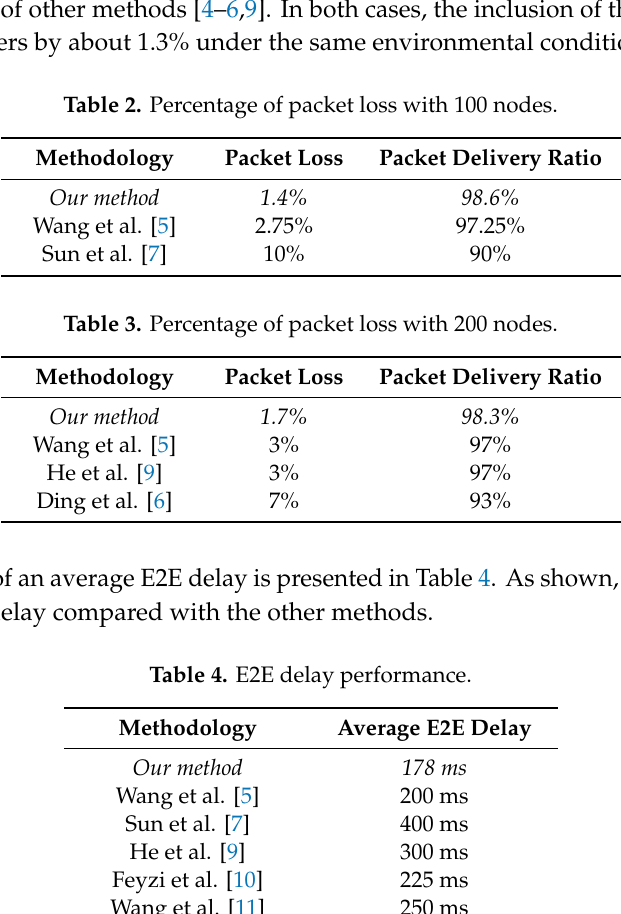
Figure 9. Throughput vs. the number of cars.